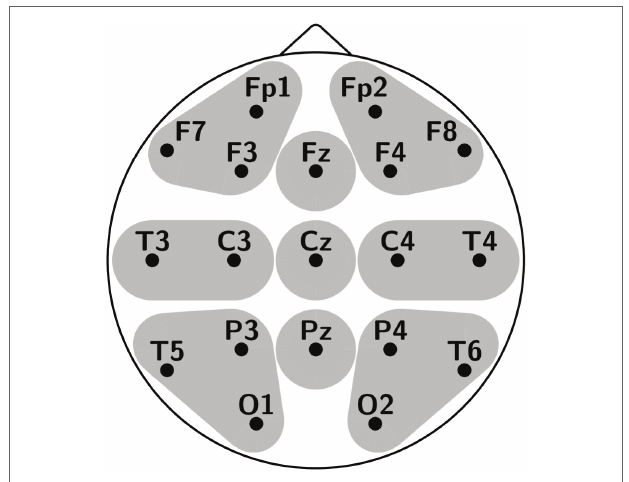
FIGURE 1 | Electrode montage with regions used for